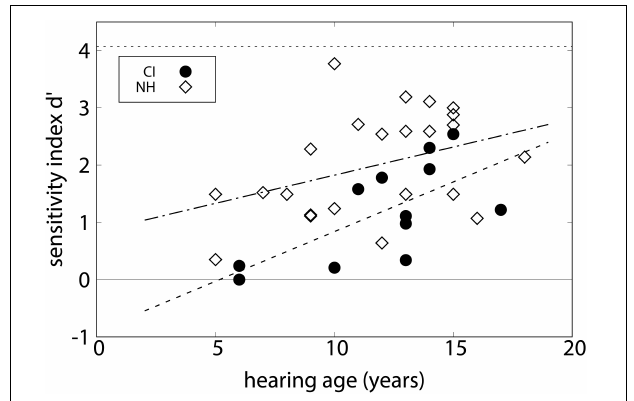
FIGURE 2 | Sensitivity index d (cid:48) for experiment 1 (chord discrimination task) for individual CI (circles) and NH listeners (diamonds), as a function of hearing age. The lines show linear regressions to the